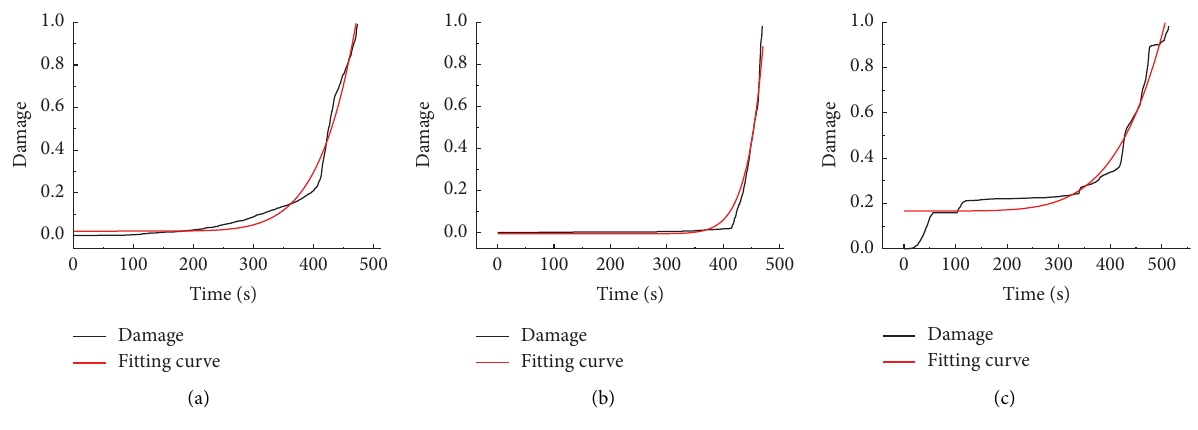
Figure 7: Coal sample damage ftting curve: (a) N1; (b) NF1; (c) SF1. Table 2: Coal sample damage and time ftting parameters. Coal